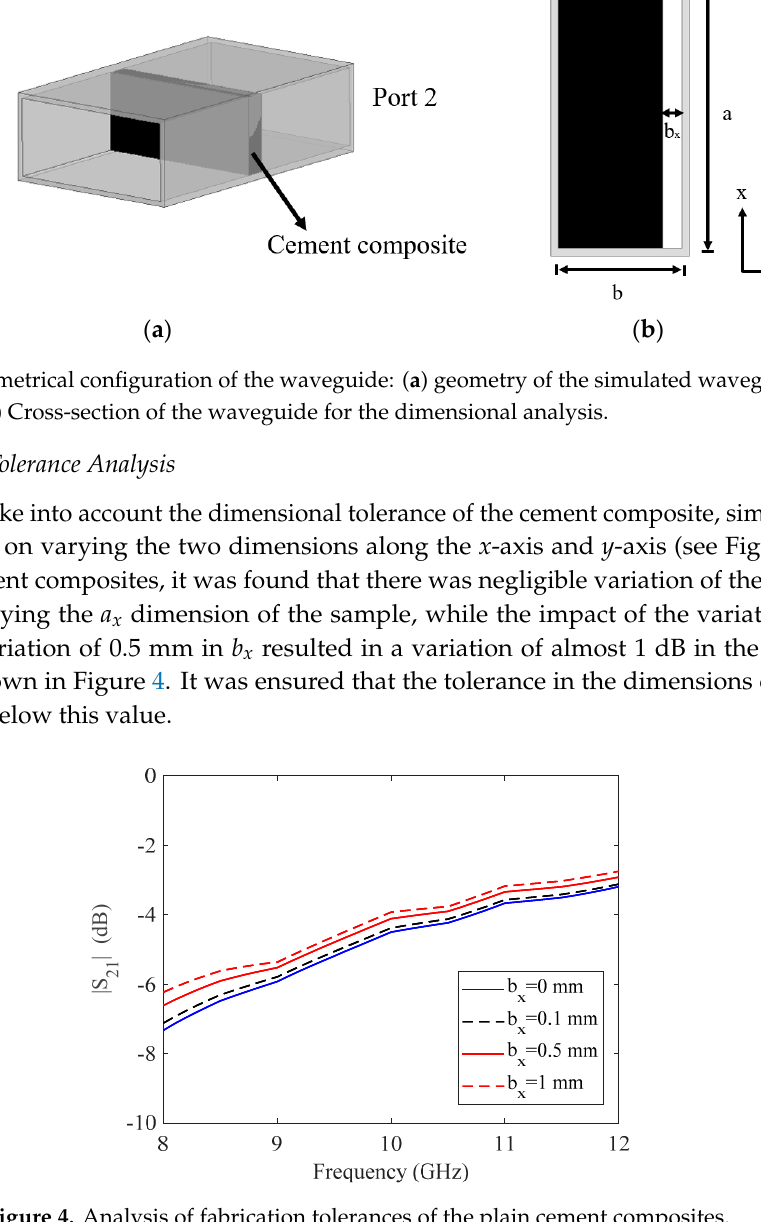
Figure 4. Analysis of fabrication tolerances of the plain cement composites.